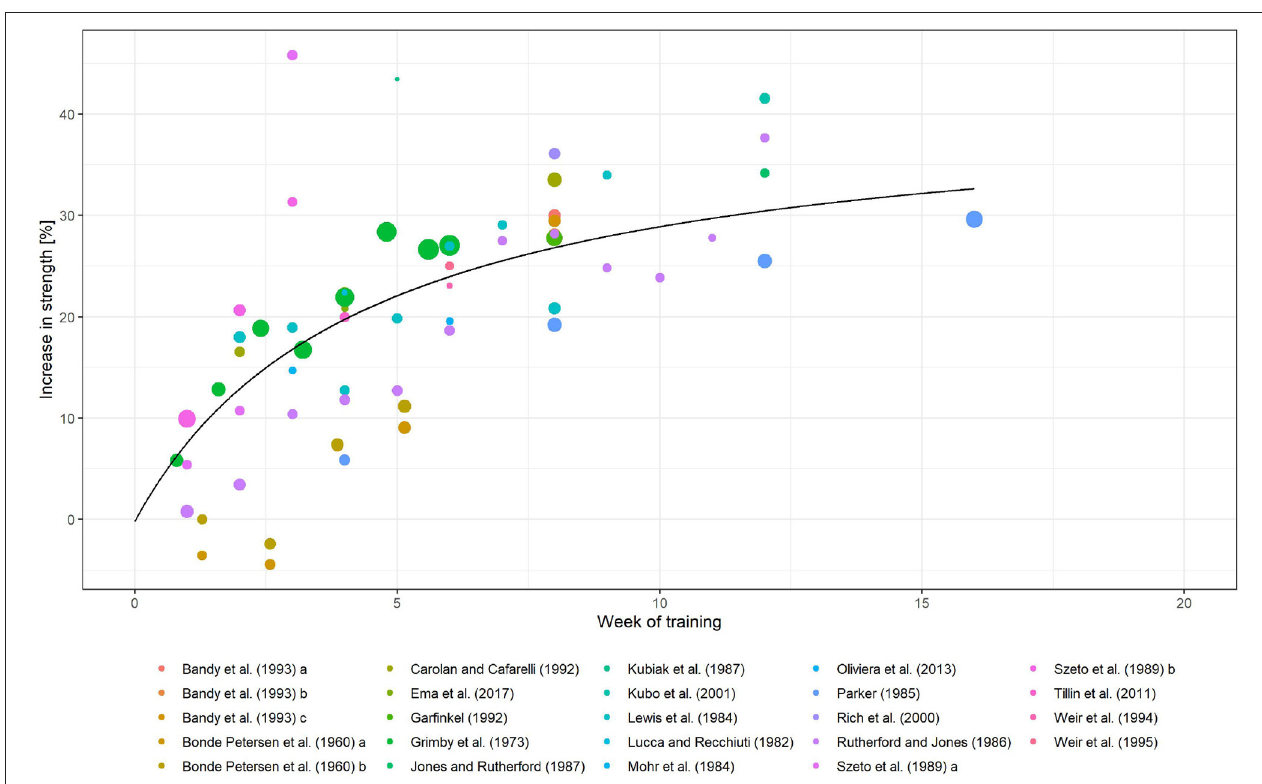
FIGURE 4 | Fitted Emax model (black line) for the relative change in isometric strength over weeks trained together with data points obtained from multiple studies (colored dots). Note that the size of the colored dots are proportional to the subject size of a given study.